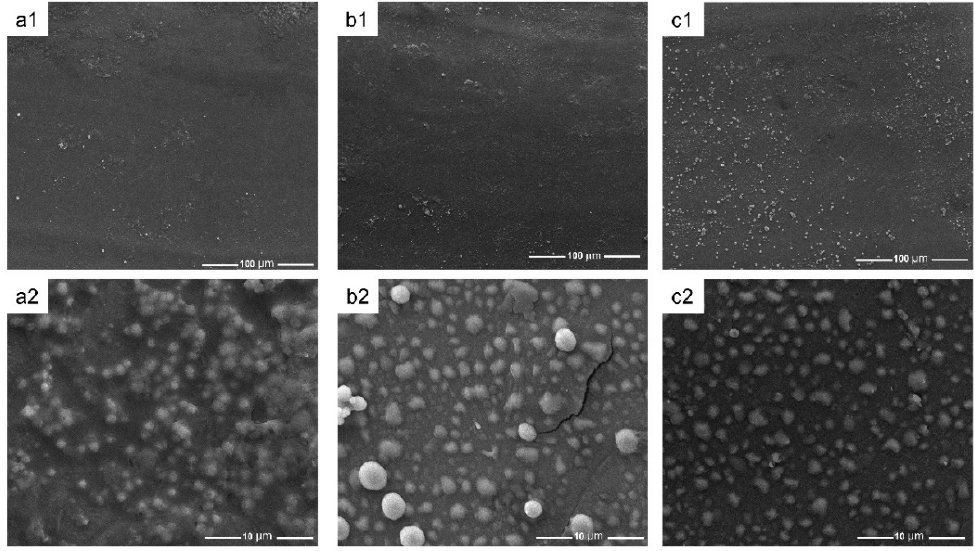
Figure 9. SEM of ( a ) PDA/PLA-4 h (( a1 ) 1000×, ( a2 ) 10,000×); ( b ) PDA/PLA-8 h (( b1 ) 1000×, ( b2 ) 10,000×); ( c ) PDA/PLA-12 h (( c1 ) 1000×, ( c2 ) 10,000×) after 7 days of in vitro mineralization.